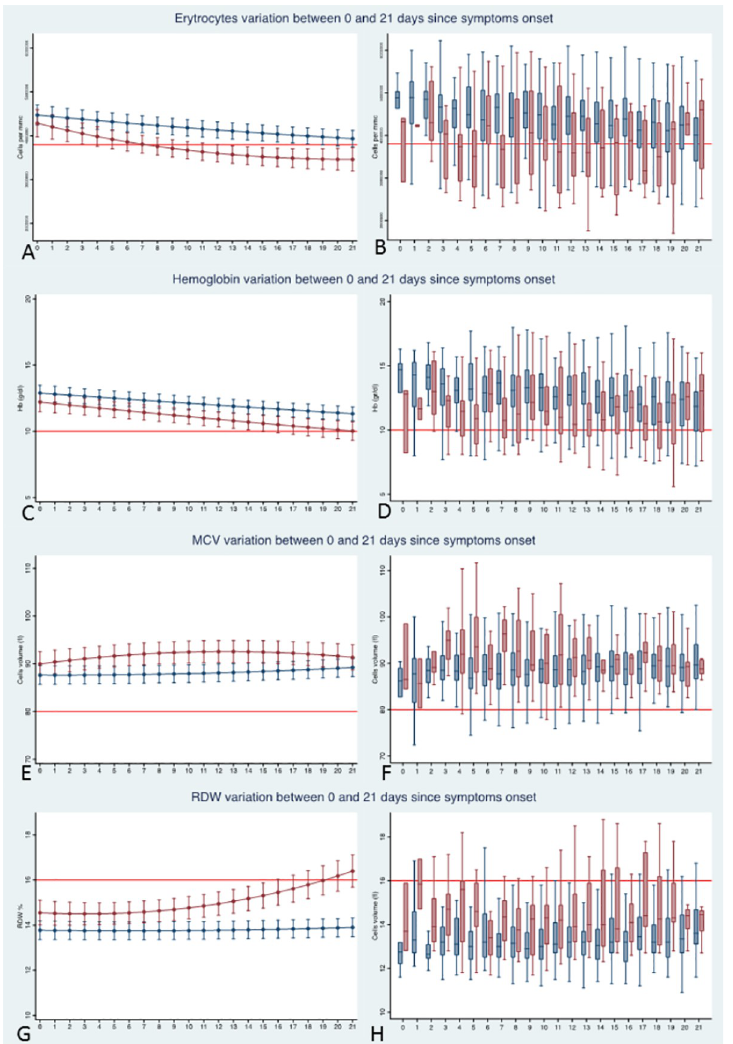
Fig 3. Plots of predicted values and box plots of observed values of average erythrocytes counts (A, B), Hb level (C, D), MCV (E, F) and RDW percentage (D, H) over time for survivors (blue line and boxes) and non-survivors (red line and boxes). In the box plots, the outliers are not displayed. All estimates were made on the full dataset, including 1805 determinations on the 379 patients. The red line in plots A and B marks the lower normal limit of erythrocytes (3.8 million cell/mmc). The red line in plots C and D marks the lower normal limit of Hb (10 mg/dL). The red line in plots E and F marks the normal MCV value (80 fL). The red line in plot G and H marks the lower normal average percentages of RDW